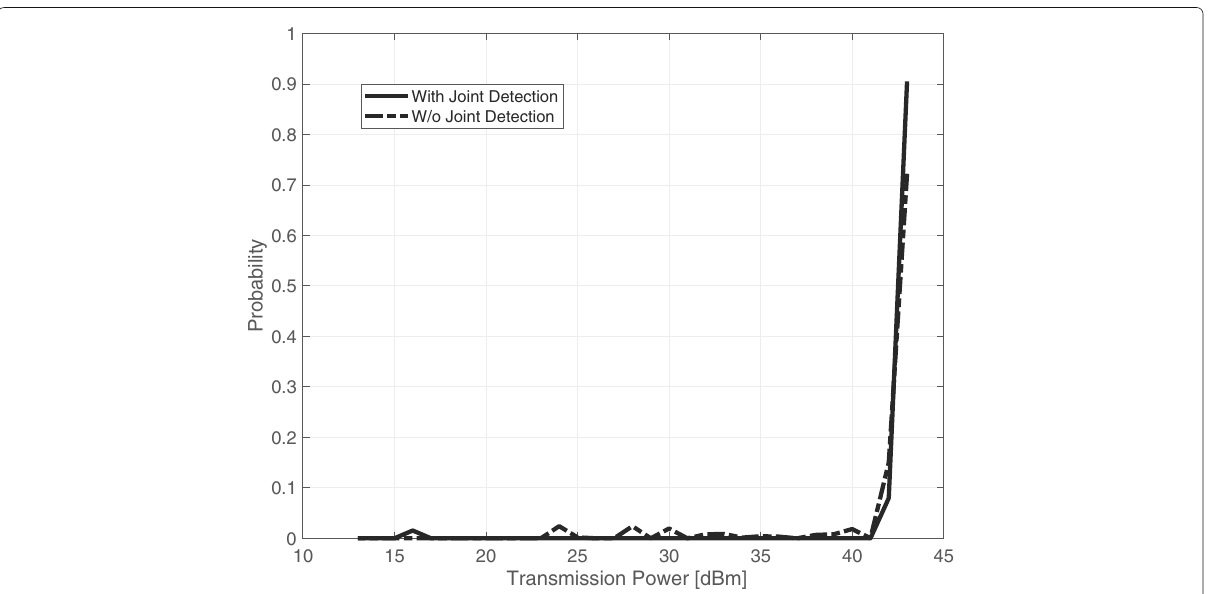
Fig. 11 Probability distribution of MBS transmission power (5 users/sector, PBS: 2(cell radius)/3)